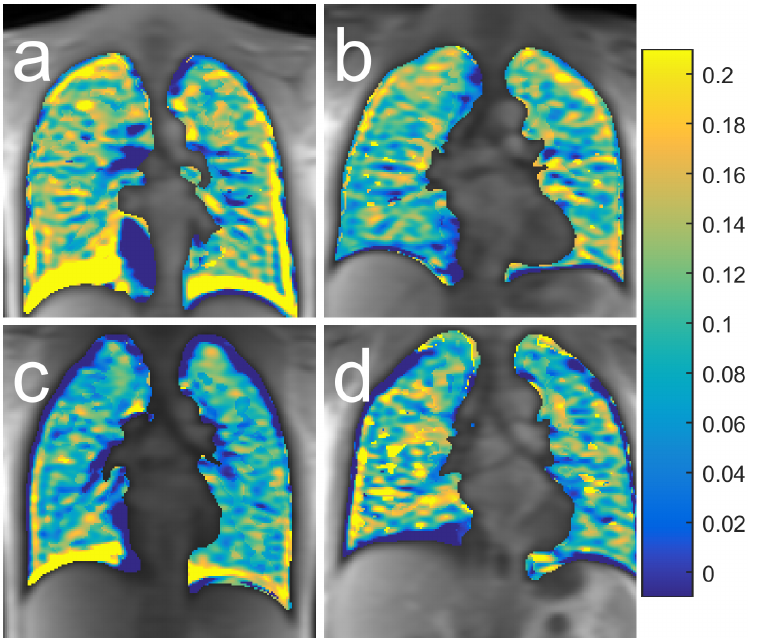
Fig 1. Oxygen enhancement images from four subjects. Representative maps of Δ R 1 = R1,oxygen − R 1,air for a) Female age < 30 years, b) Female age > 45 years, c) Male age < 30 years and d) Male age > 45 years. The images are provided for completeness, and are not registeredor